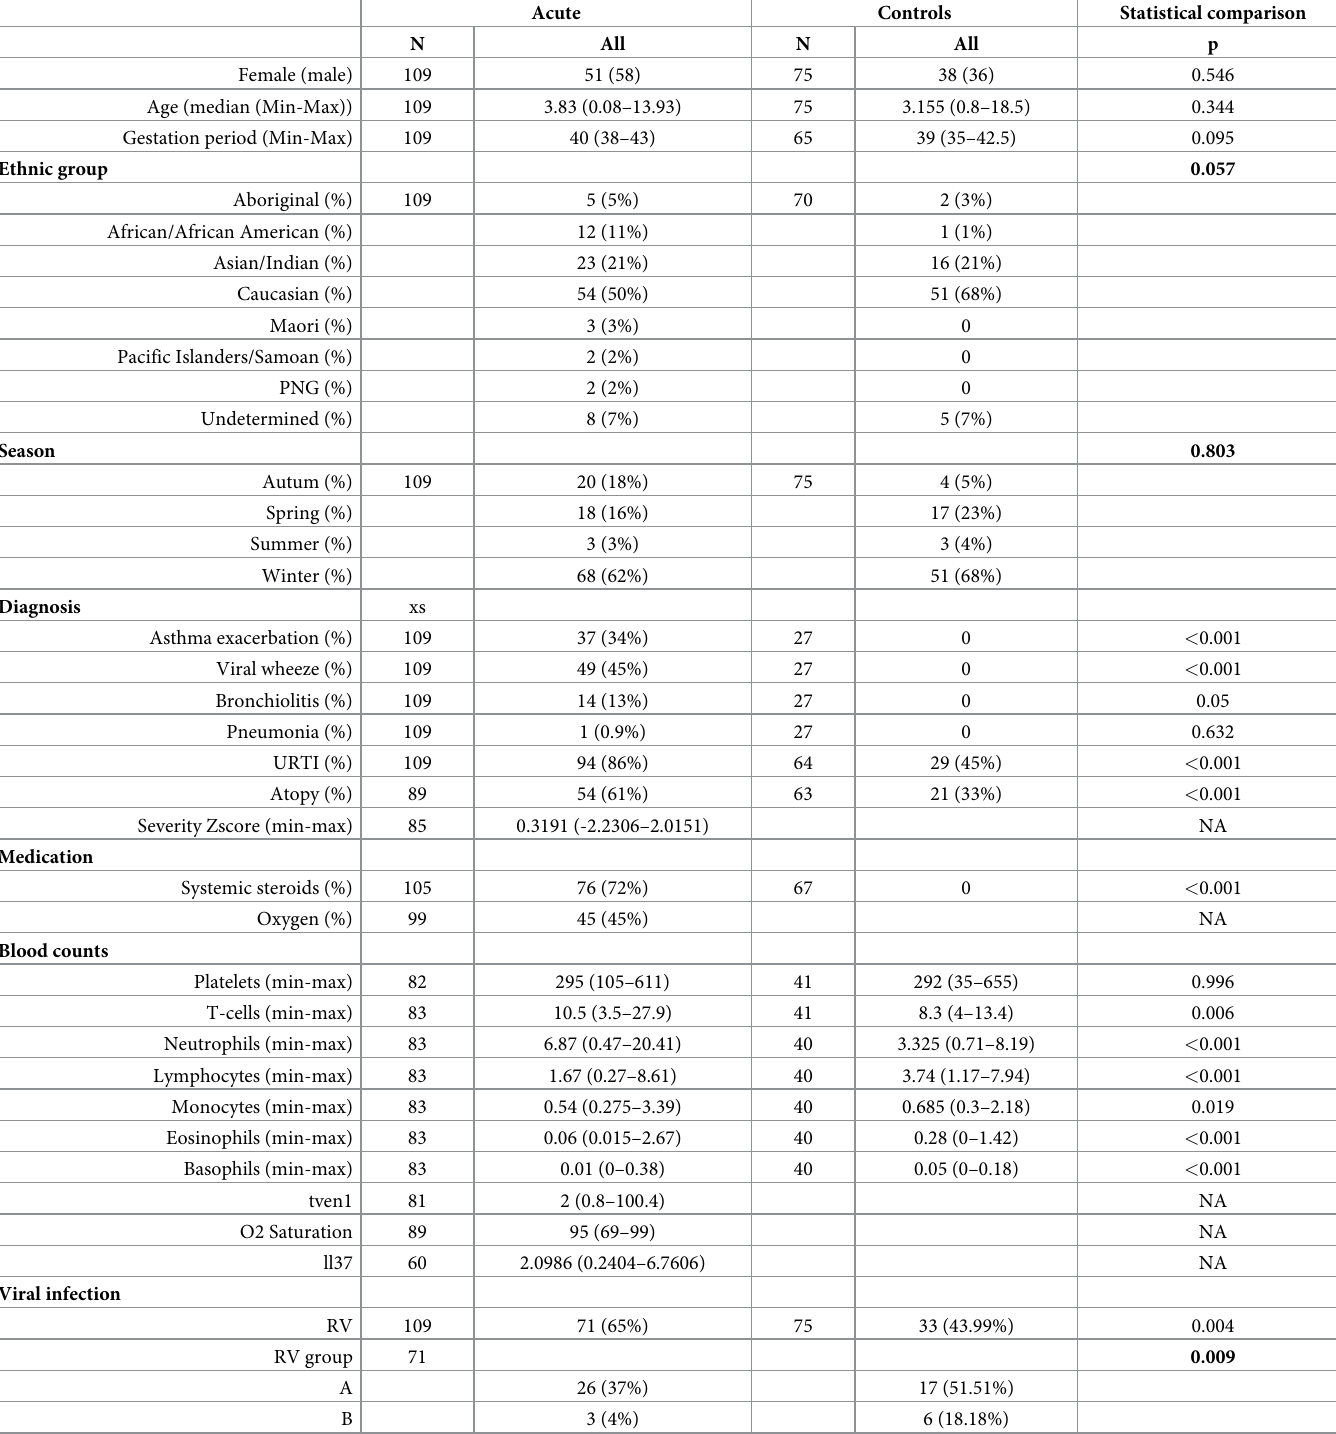
Table 1. Demographic table of acute cases and healthy controls. Data indicates counts for cases (acute wheeze diagnosis) and healthy controls. N indicates the total number of subjects that information was obtained for each group. Count data is indicted as a count (% positive of N). Continuous data is recorded at median of N